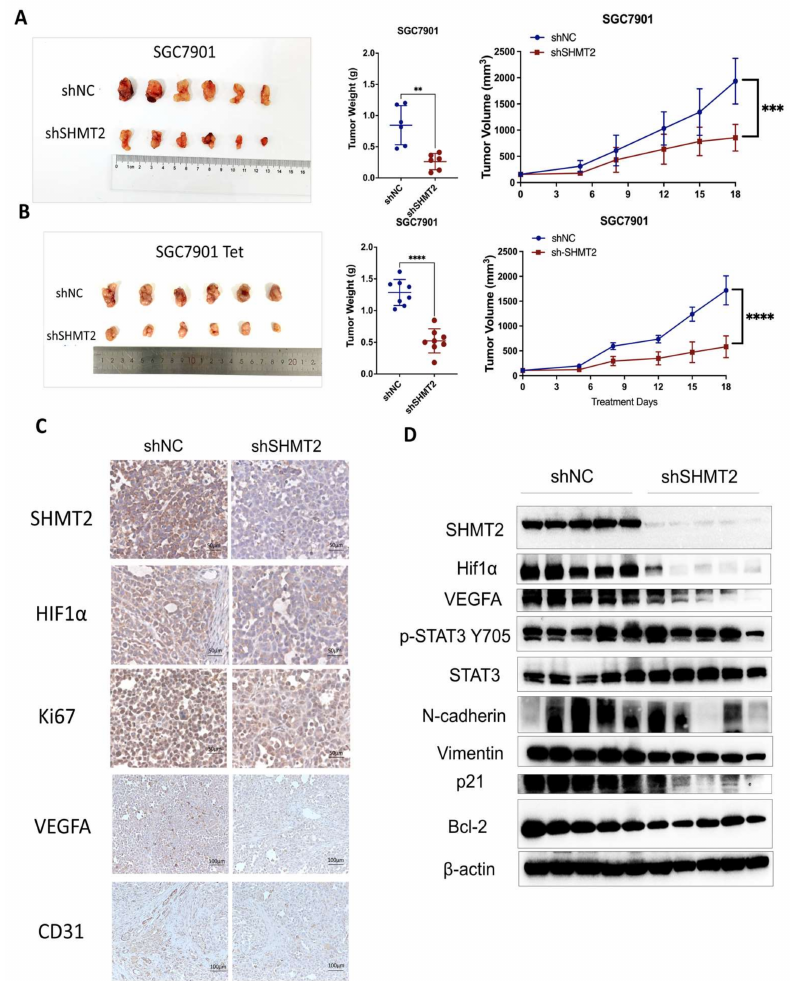
Figure 7. SHMT2 knockdown inhibited GC cell growth in a mice xenograft model in vivo. ( A ) shNC and shSHMT2 cells (2 × 10 6 cell/mouse) were subcutaneously injected into BALB/c-nude mice ( n = 6); tumor growth curves and tumor images of experimental endpoints as well as tumor weights. ( B ) shNC and shSHMT2 transient knockdown GC cells (2 × 10 6 cell/mouse) were subcutaneously injected into BALB/c-nude mice ( n = 6), and 2 g/L of DOX and 5% of sucrose were added to the daily drinking water of the mice; tumor growth curves and tumor images at the end of the experiment and tumor weights. ( C ) Representative IHC staining of xenograft tumors for SHMT2, Ki67, HIF1 α , VEGFA, and CD31. ( D ) Western blotting of SHMT2, HIF1 α , VEGFA, p-STAT3 (Y705), STAT3, N-cadherin, vimentin, p21, Bcl-2, and β -actin in xenograft tumor tissues, n = 5. ** p < 0.01, *** p < 0.001, and **** p <